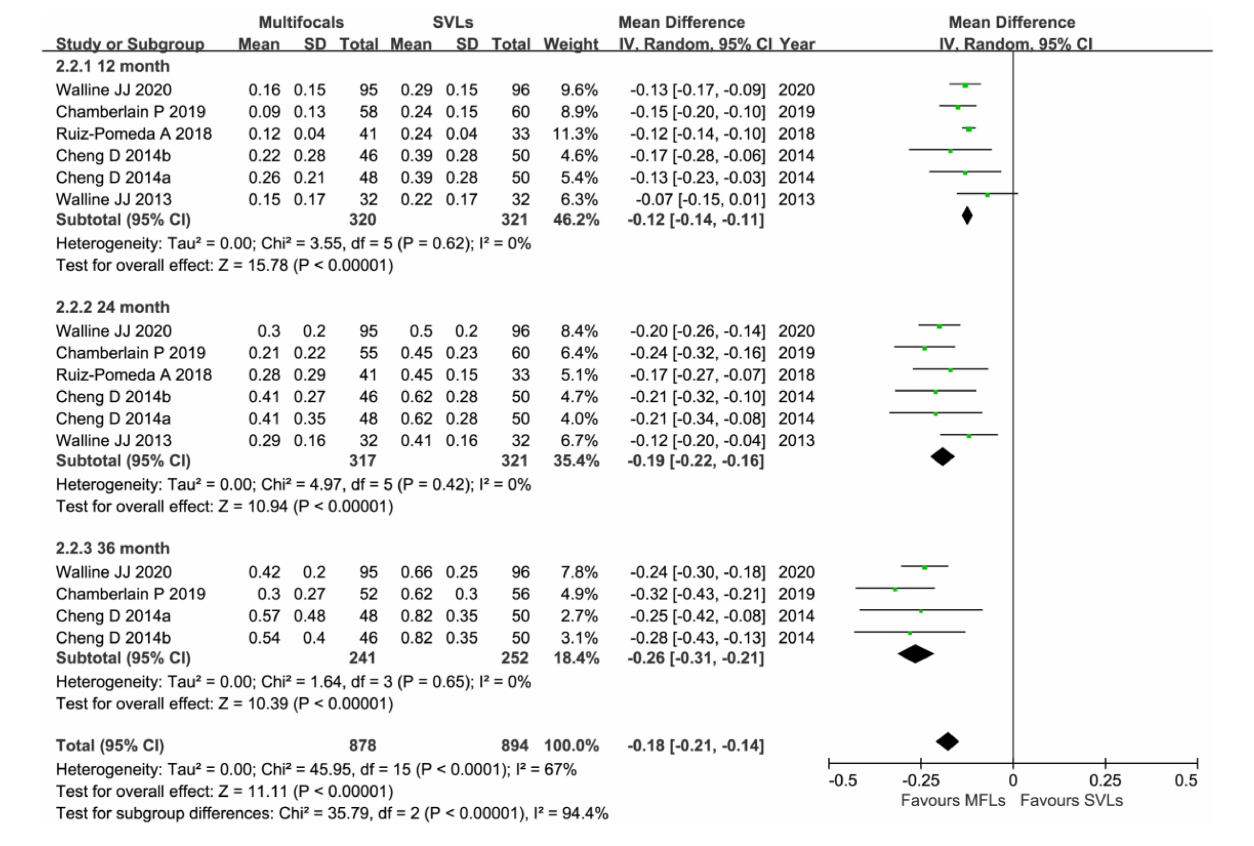
FIGURE 4 | Forest plot about the change of AL in annual interval visit